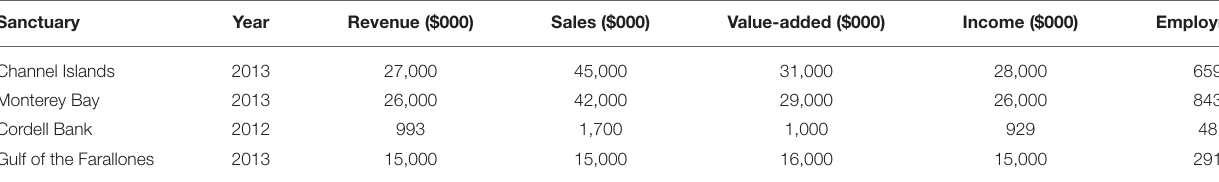
TABLE 1 | Economic impacts of commercial fishing in California’s National Marine Sanctuaries.